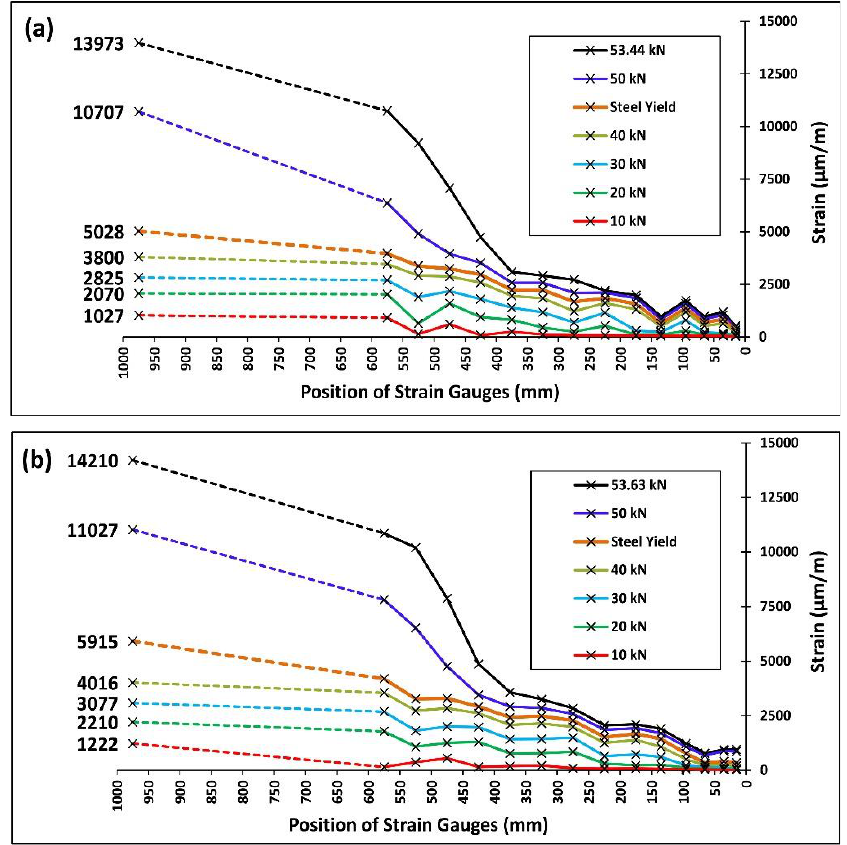
Figure 13. Strain distributions along one half of the CFRP strip at different levels of load for specimens ( a ) SB1S-1-R and ( b ) SB1S-1-40.